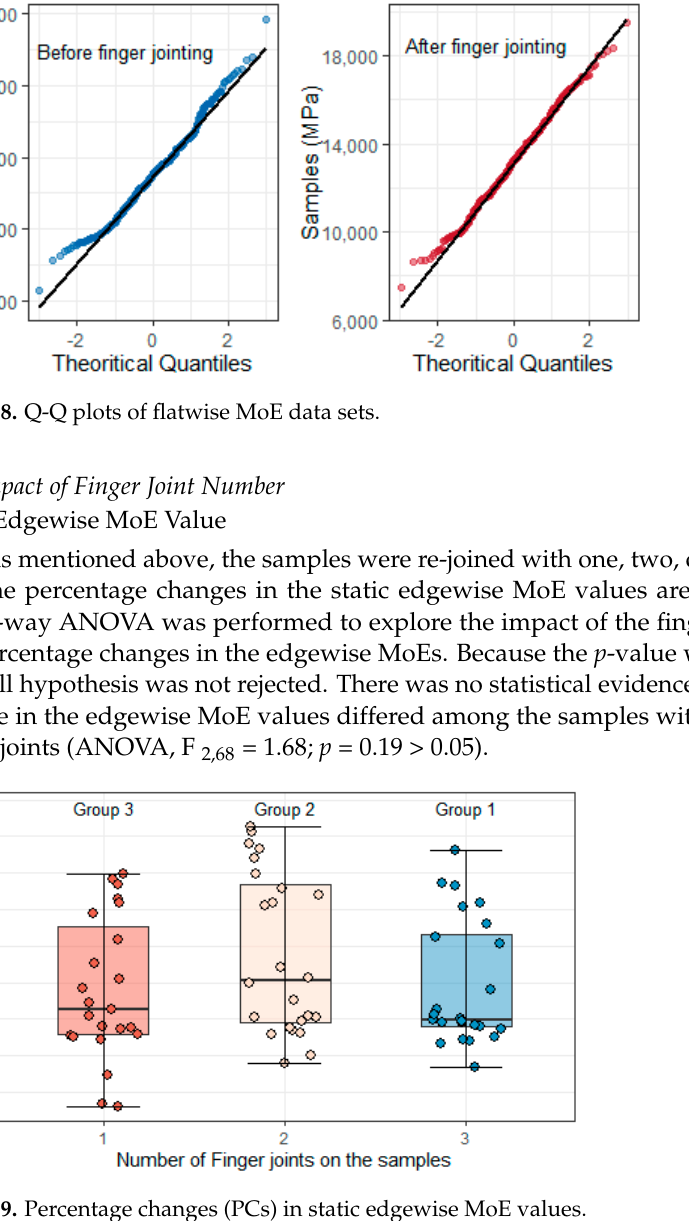
Figure 8. Q-Q plots of flatwise MoE data sets.